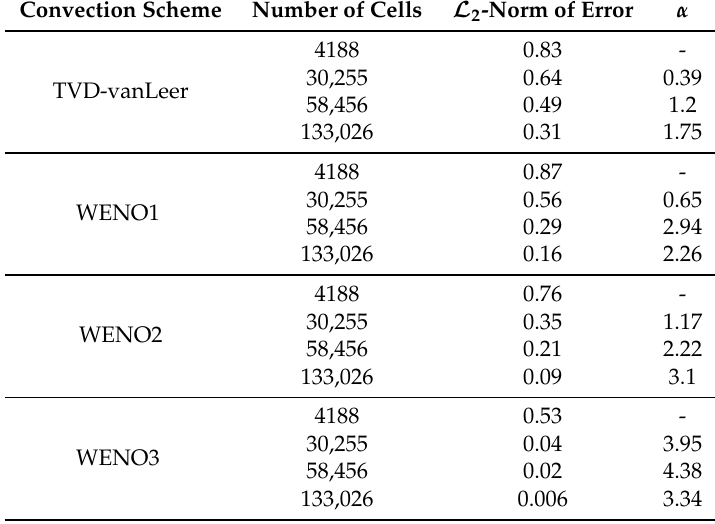
Table 4. Error and convergence of WENO convection schemes for the advection equation on tetrahedral